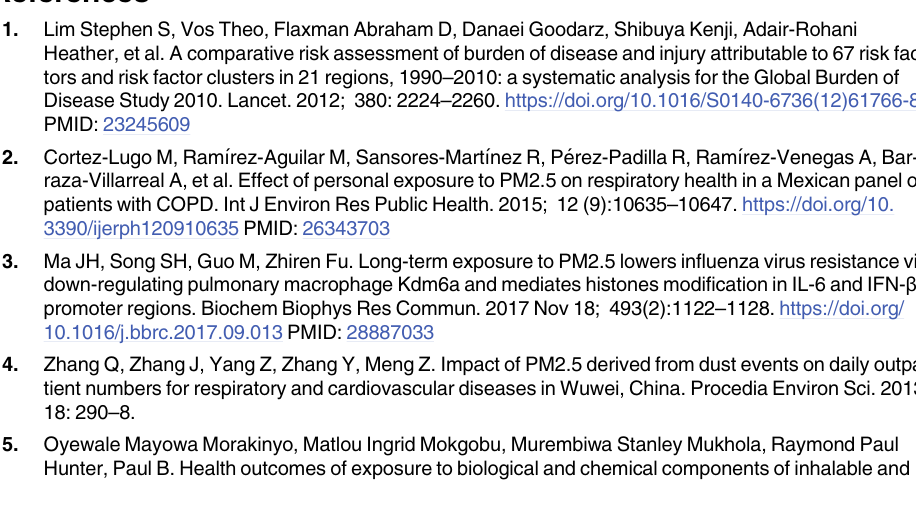
S2 Table. The percent change of daily stroke morbidity in every 10 μ g/m3 increase of PM2.5 to different genders and age groups under different lag of days. S3 Table. The number of missing data of each air monitoring station of 3 years. S4 Table. The sensitivity analysis by changing the df of the long-term trend. (DOCX) S5 Table. The raw data needed to replicate the findings of this study.